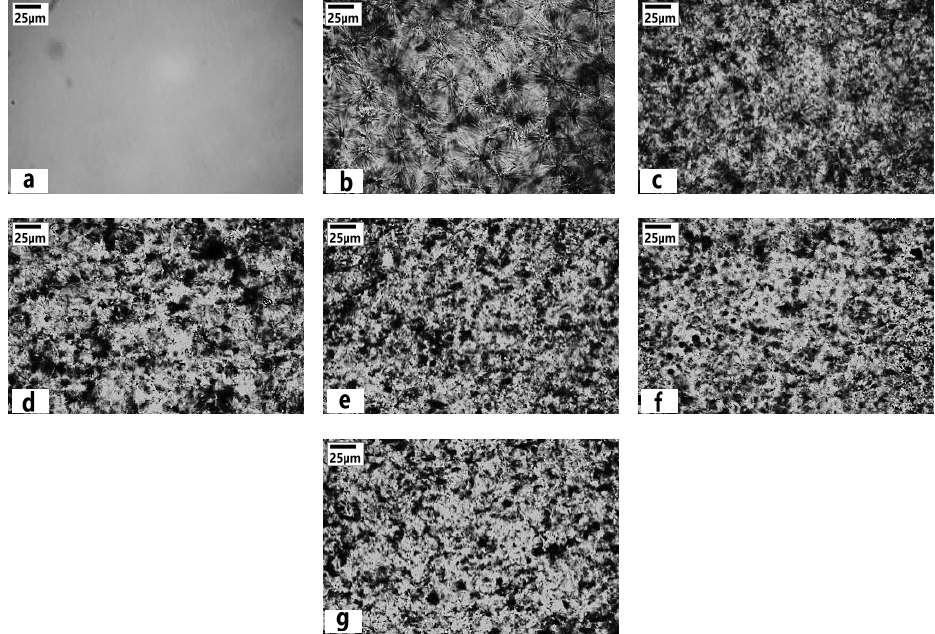
Figure 2. Morphology of pure ( a ) LMPP, ( b ) iPP, ( c ) 5%, ( d ) 10%, ( e ) 15%, ( f ) 20% and ( g ) 25% LMPP blend crystals (adapted from [29]).